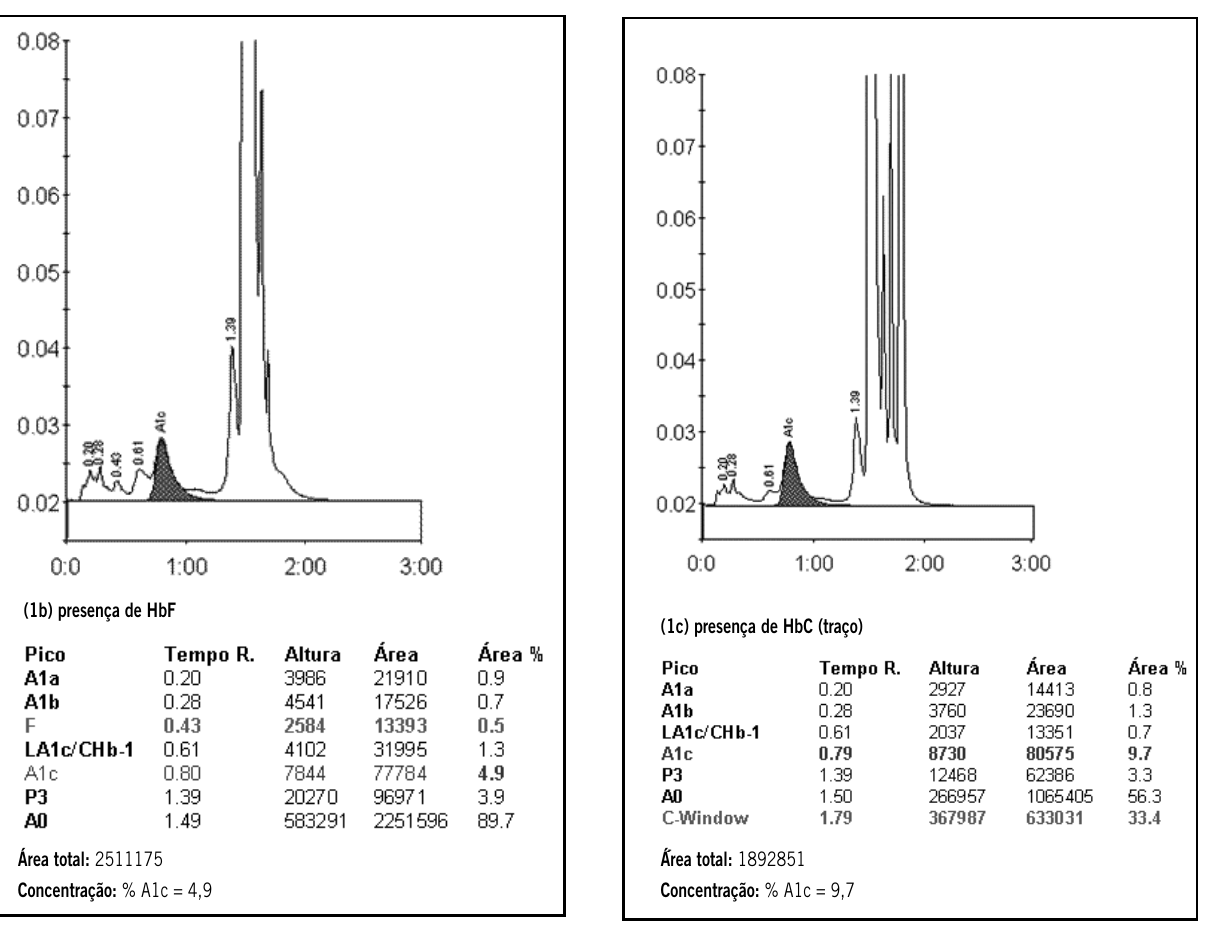
Figura 1c – Cromatograma de hemoglobinas glicadas e parâmetros de análise por CLAE, equipamento D10, Bio Rad; (c) presença de HbC (traço). Pico de